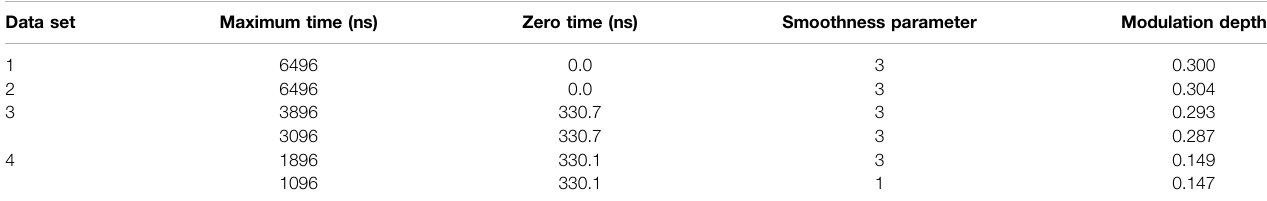
TABLE 3 | LongDistances parameters. Data